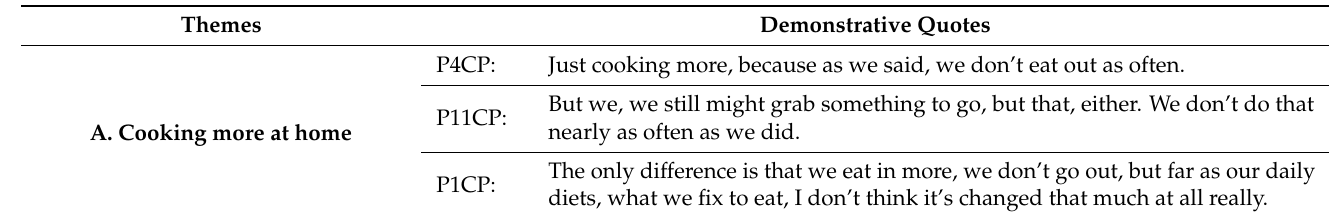
Table 4. Themes identified through dyadic interviews with PwPs and their care-partners about the impact of COVID-19 pandemic on food-related